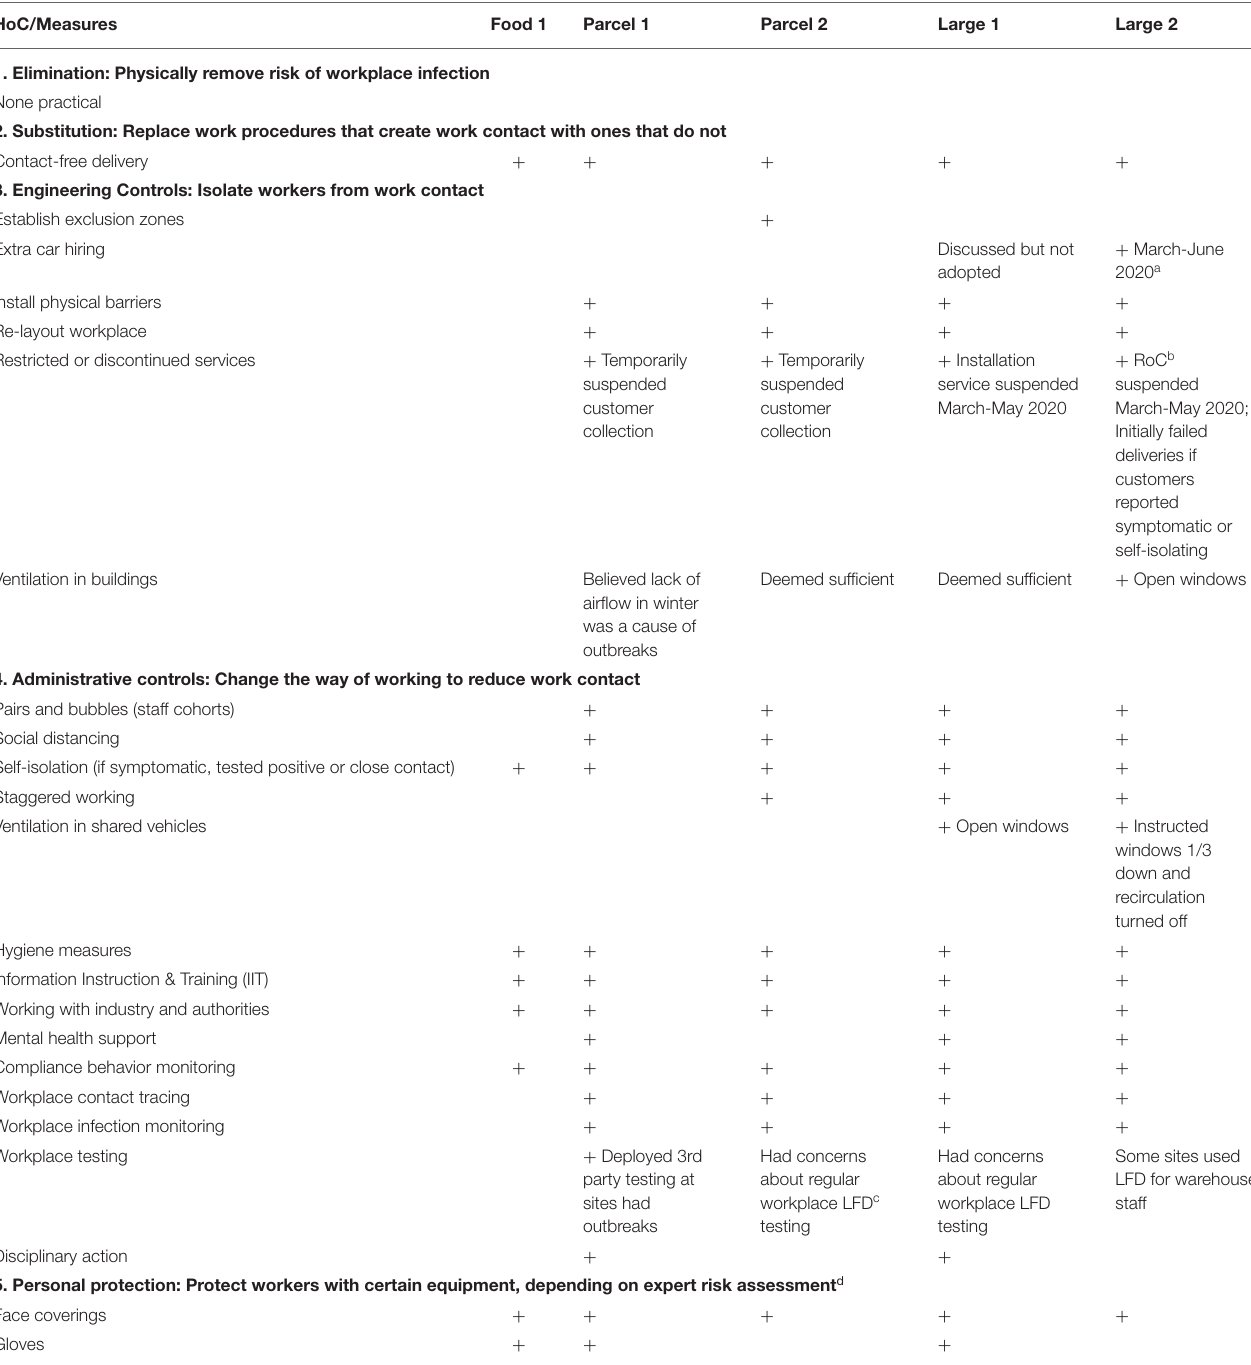
TABLE 1 | HoC analysis – COVID-19 RMMs implemented by the logistics companies for delivery